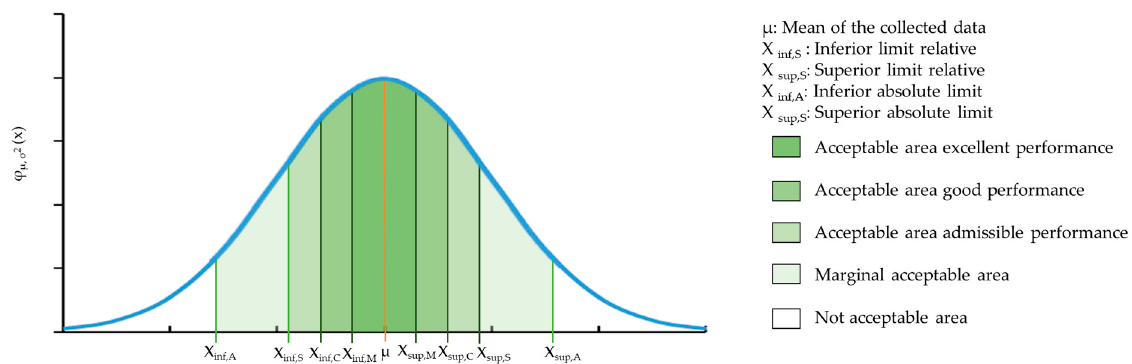
Figure 8. Gaussian distribution probability density function (PFD) with thresholds for each skill level.